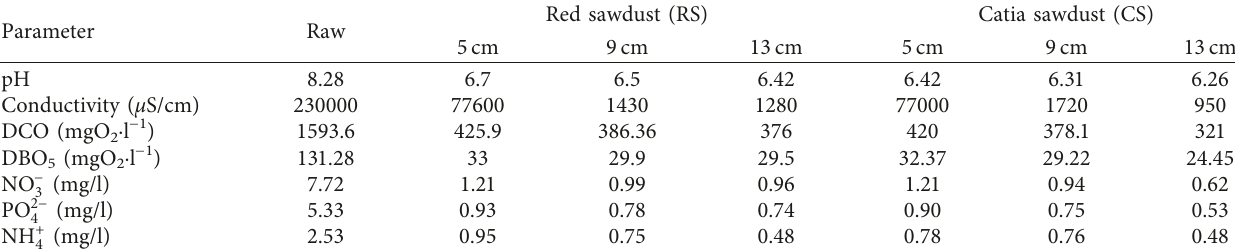
Table 2: Release standards established by the World Health Organization and Moroccan ones.